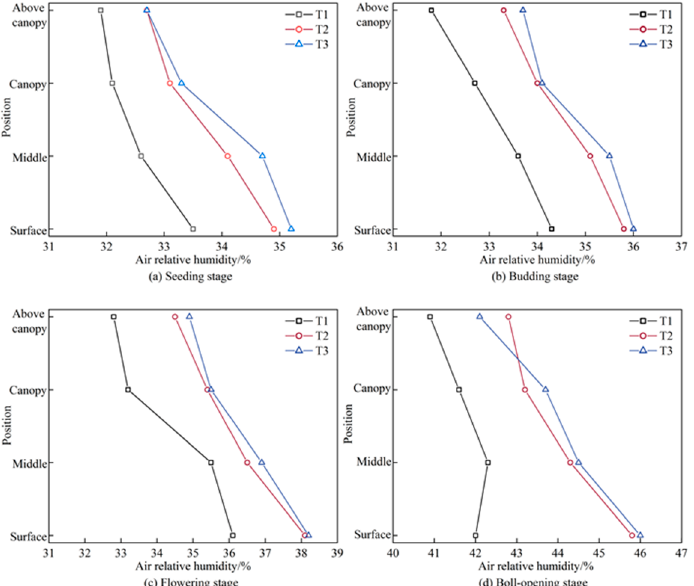
Figure 5. The relative humidity changes at different growth stages and locations under different irrigation methods: ( a ) is the variation of seeding stage; ( b ) is the variation of budding stage; ( c ) is the variation of flowering stage; ( d ) is the variation of Boll-opening stage. Table 3. Effects of different irrigation methods on soil